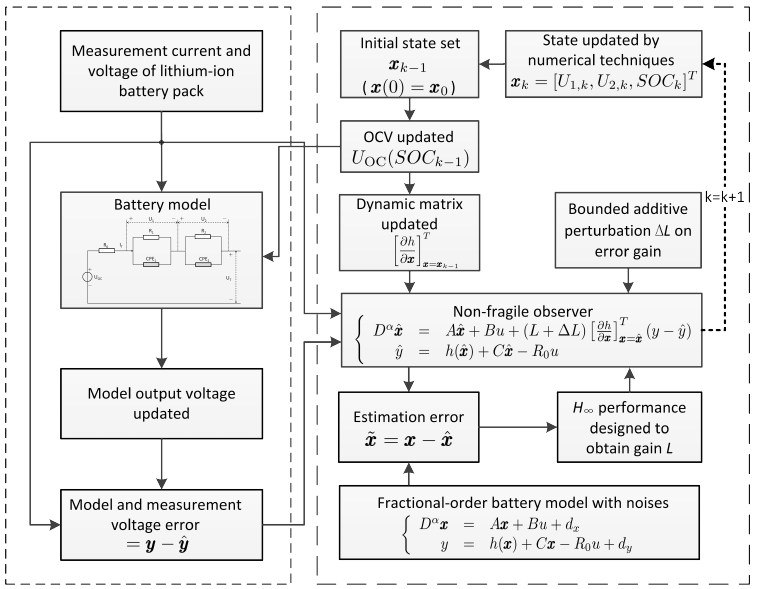
Figure 5. The implement flowchart of non-fragile H ∞